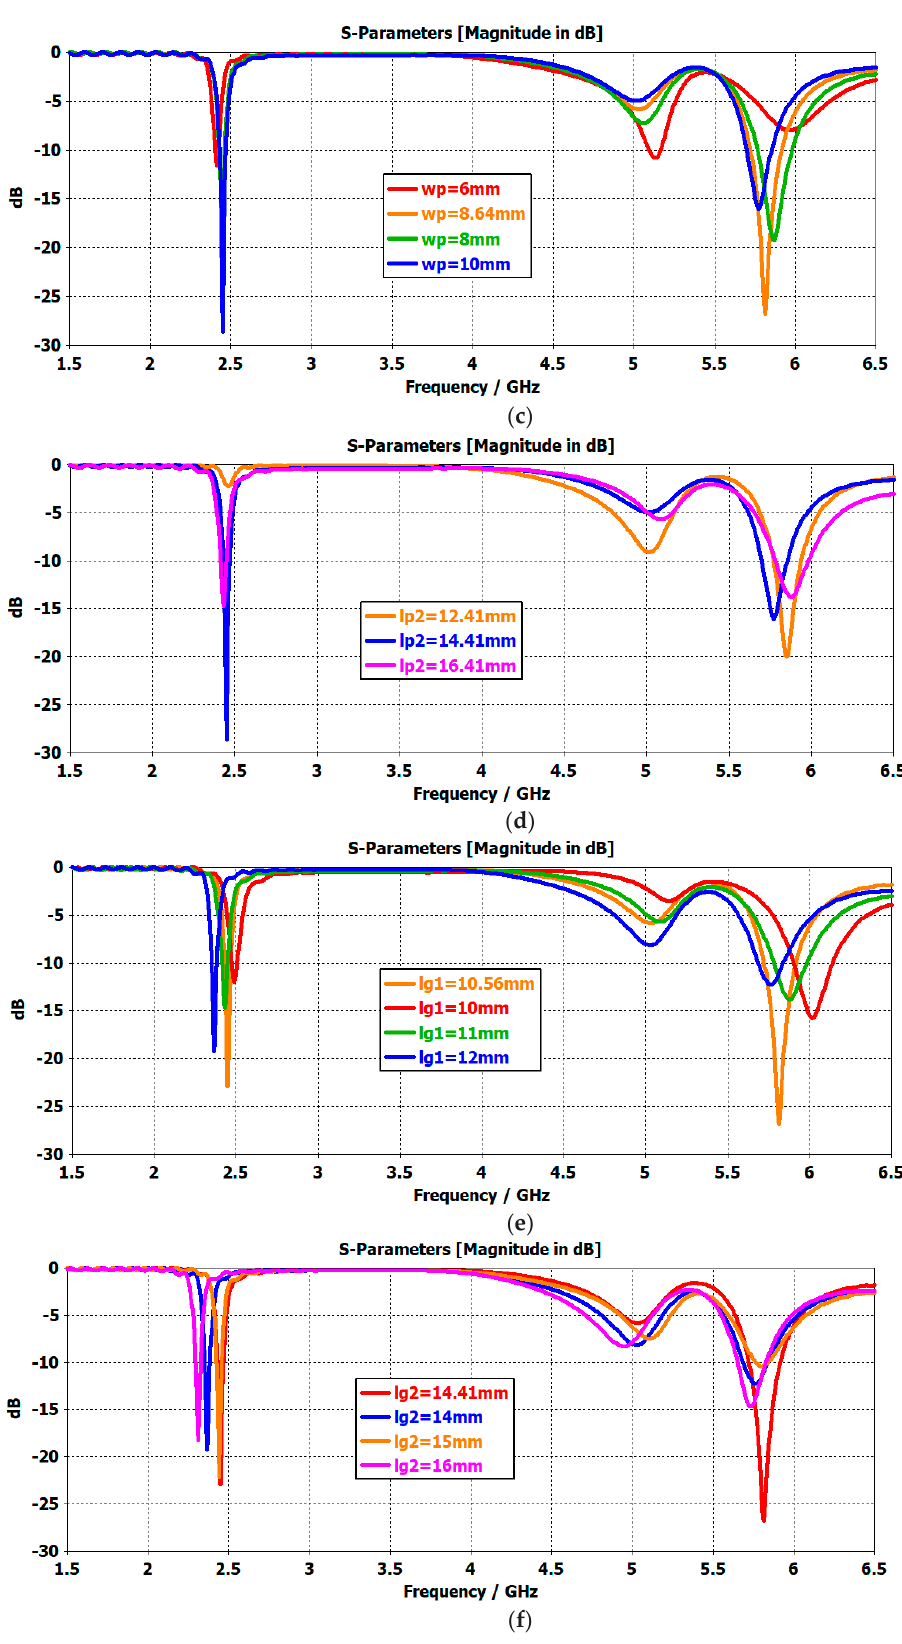
Figure 6. Parametric study of the antenna and the reflection coefficient [magnitude in dB] of: ( a ) “ 𝑤𝑝𝑠 ”; ( b ) “ 𝑙𝑝𝑠 ”; ( c ) “ 𝑤𝑝 ”; ( d ) “ 𝑙𝑝2 ”; ( e ) “ 𝑙𝑔1 ”; ( f ) “ 𝑙𝑔2 ”.